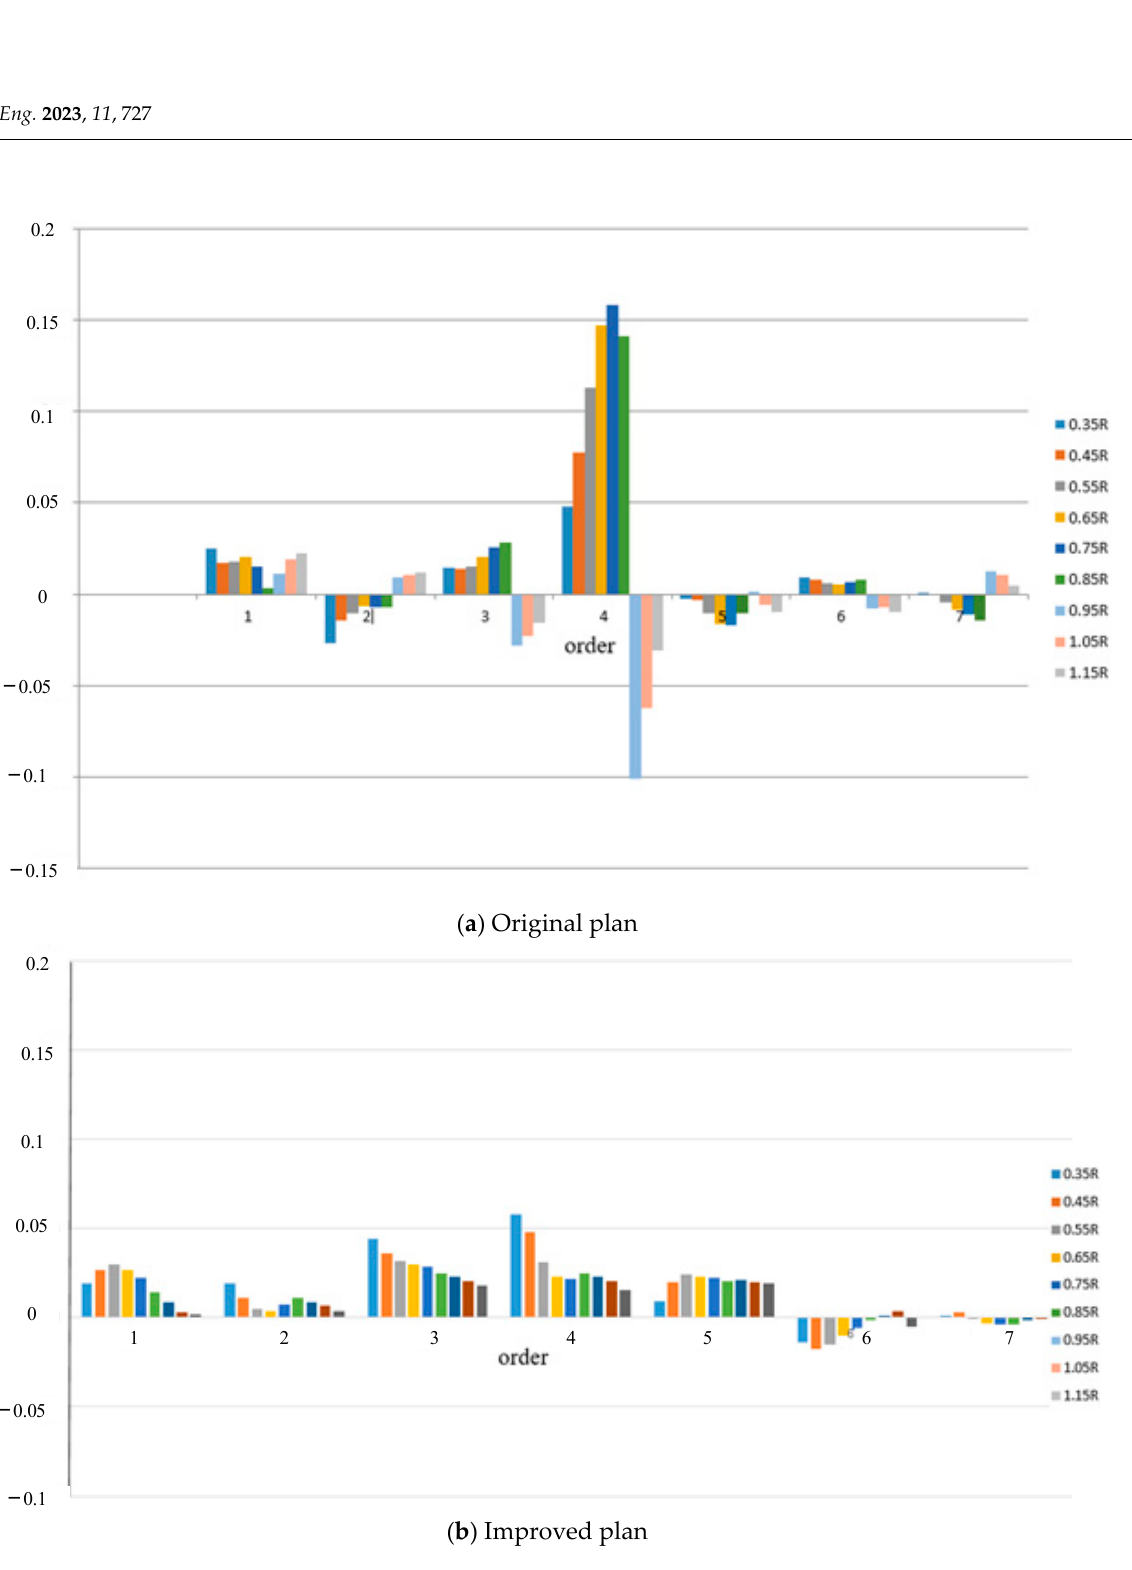
Figure 11. The comparison of the wake harmonic